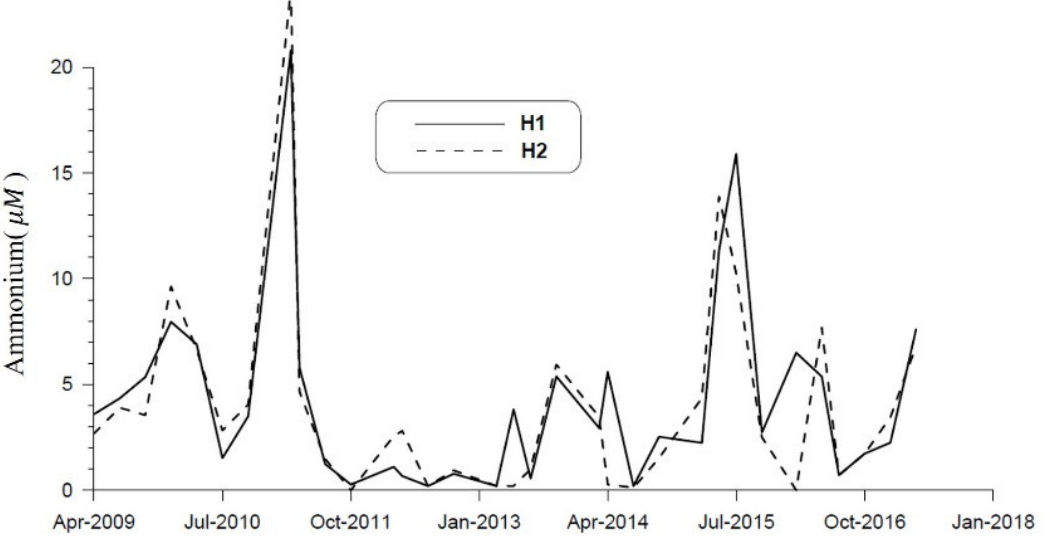
Figure 2. Two unequal interval time series of ammonium at stations H1 (solid line) and H2 (dashed line) inside the harbor were sampled from 2009 to 2016. The time-series variations show that the H2 ammonium concentration was generally consistent that of H1.